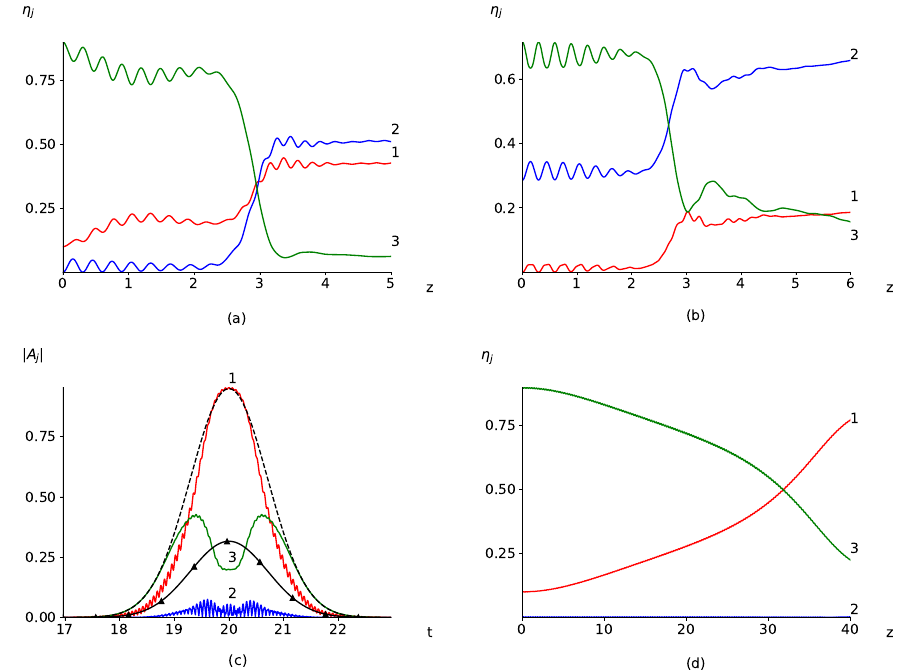
Figure 4. An evolution of the frequency conversion efficiency ( a , b , d ) along the z -coordinate and pulse shapes in the section z = 40 ( c ) computed for ( γ , | A 10 | 2 , | A 20 | 2 ) = ( 4, 0.1, 0 ) ( a ), ( 4, 0, 0.4 ) ( b ), ( 1, 0.1, 0 ) ( c , d